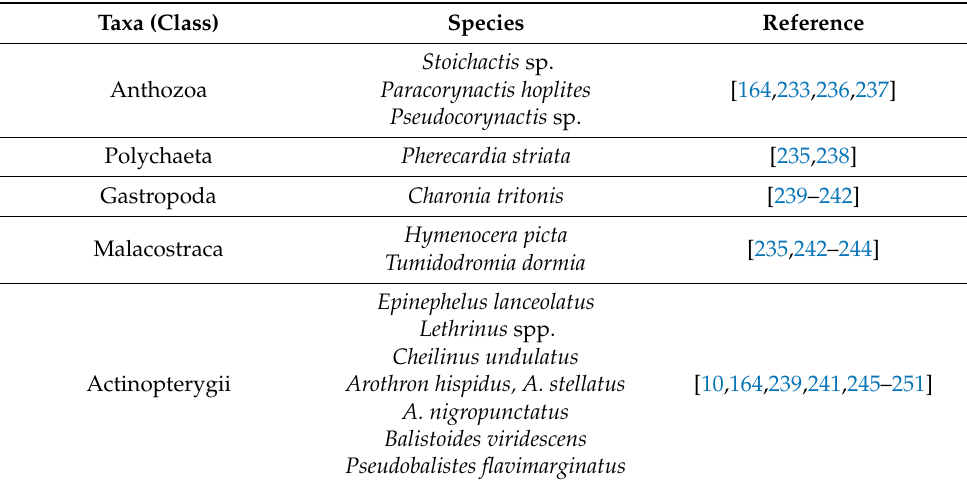
Table 5. Predators observed to prey on healthy live juvenile, sub-adult and adult Crown-of-Thorns starfish. Modified from